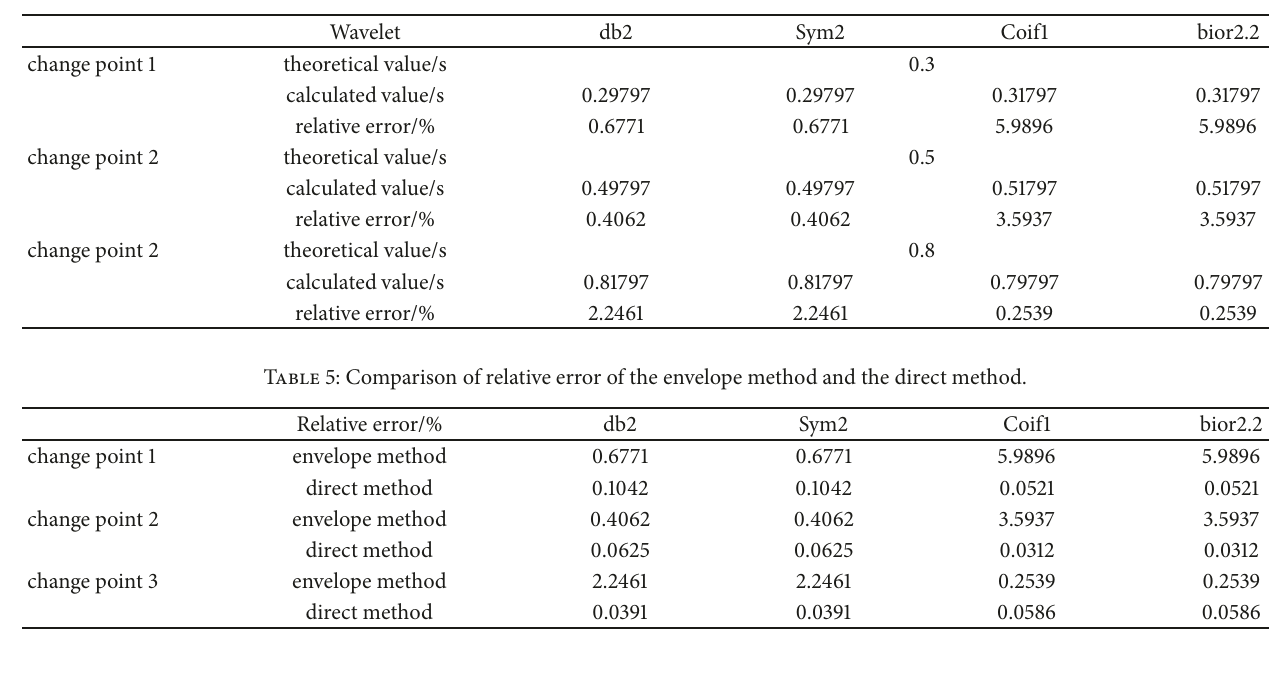
Table 4: Comparison of the theoretical value and the calculated value.